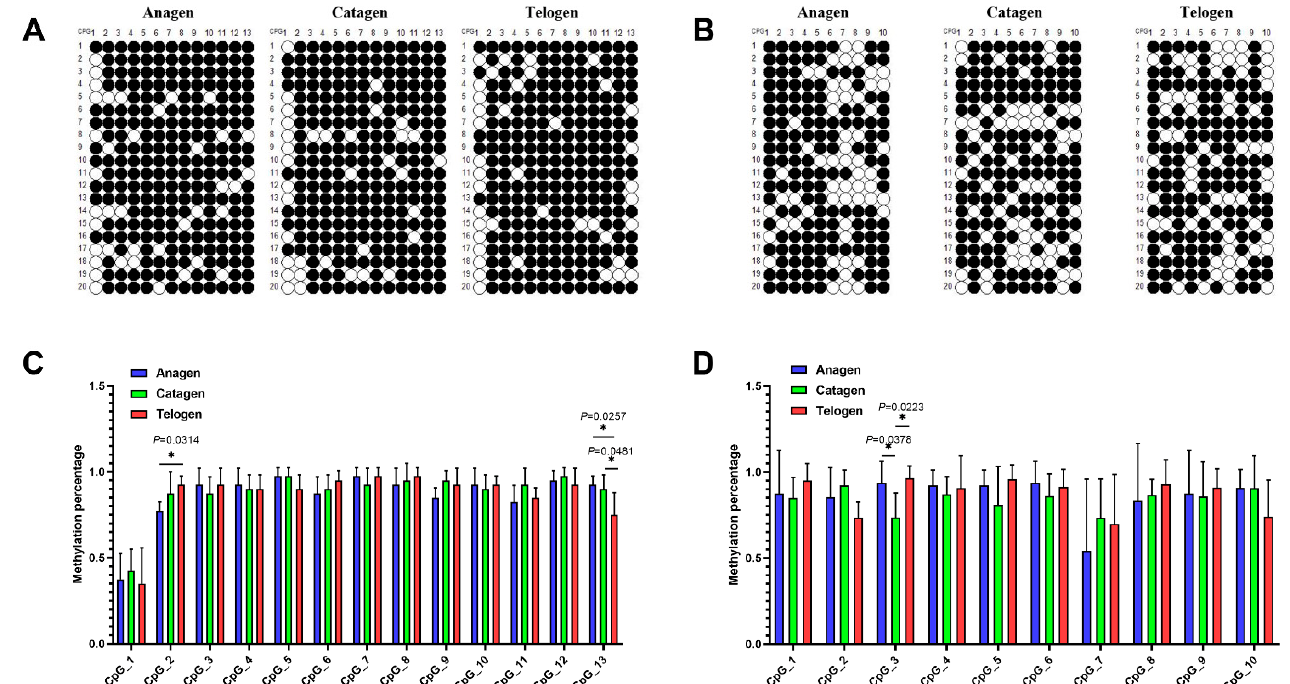
Figure 3. DNA methylation regulates the transcriptional expression of lncRNA2919. ( A ) DNA methylation detection of CpG island 1 in the lncRNA2919 promoter region during the HF cycle in Angora rabbits. ( B ) DNA methylation detection of CpG island 2 in the lncRNA2919 promoter region during the HF cycle in Angora rabbits. ( C ) Methylation percentage of CpG island 1 in the lncRNA2919 promoter region during the HF cycle. ( D ) Methylation percentage of CpG island 2 in the lncRNA2919 promoter region during the HF cycle. Data are presented as mean ± SEM. One-way ANOVA with adjusted multiple comparisons was used for data analyses. For significance, * p < 0.05.